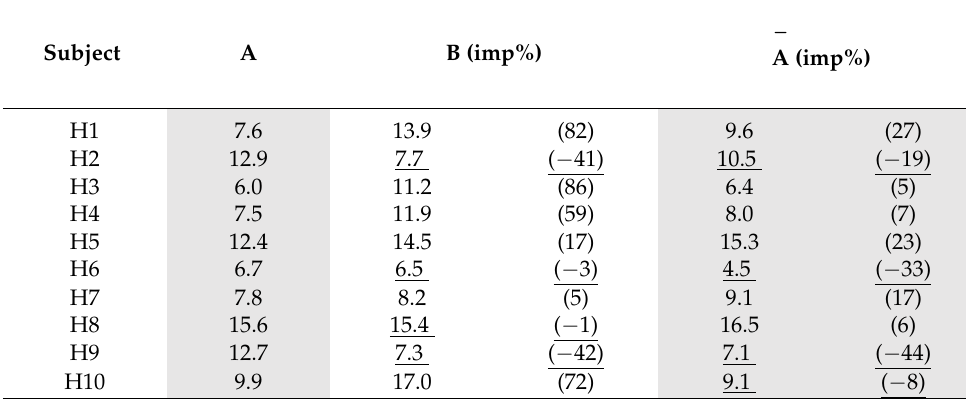
Amp . PR Amp ) using the original intervention. PR